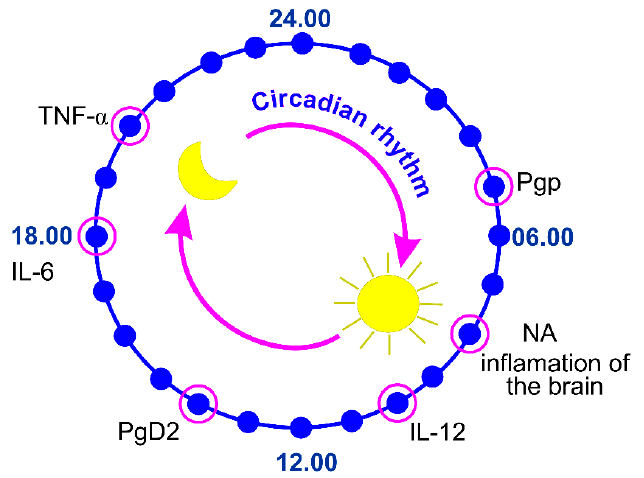
Figure 3. The biological clock of the blood–brain barrier permeability to cytokines (TNF- α , IL-6, IL-1 α ) and regulating their activity factors, such as hormones (NA and PGD2) and permeability-glycoprotein multidrug transporter (Pgp).